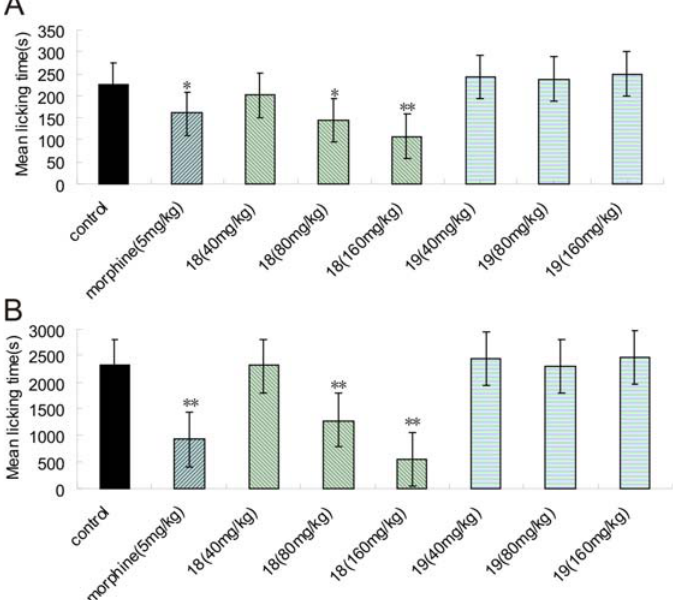
Figure 2. Effects of 18 and 19 administered po and morphine (ip) on the pain in rat. (A) the fi rst phase (0-5 min); (B) the second phase (15-60 min). Each column represents mean ± S.E.M. of ten experimental values. * In comparison to the control group. * P < 0.05; ** P <